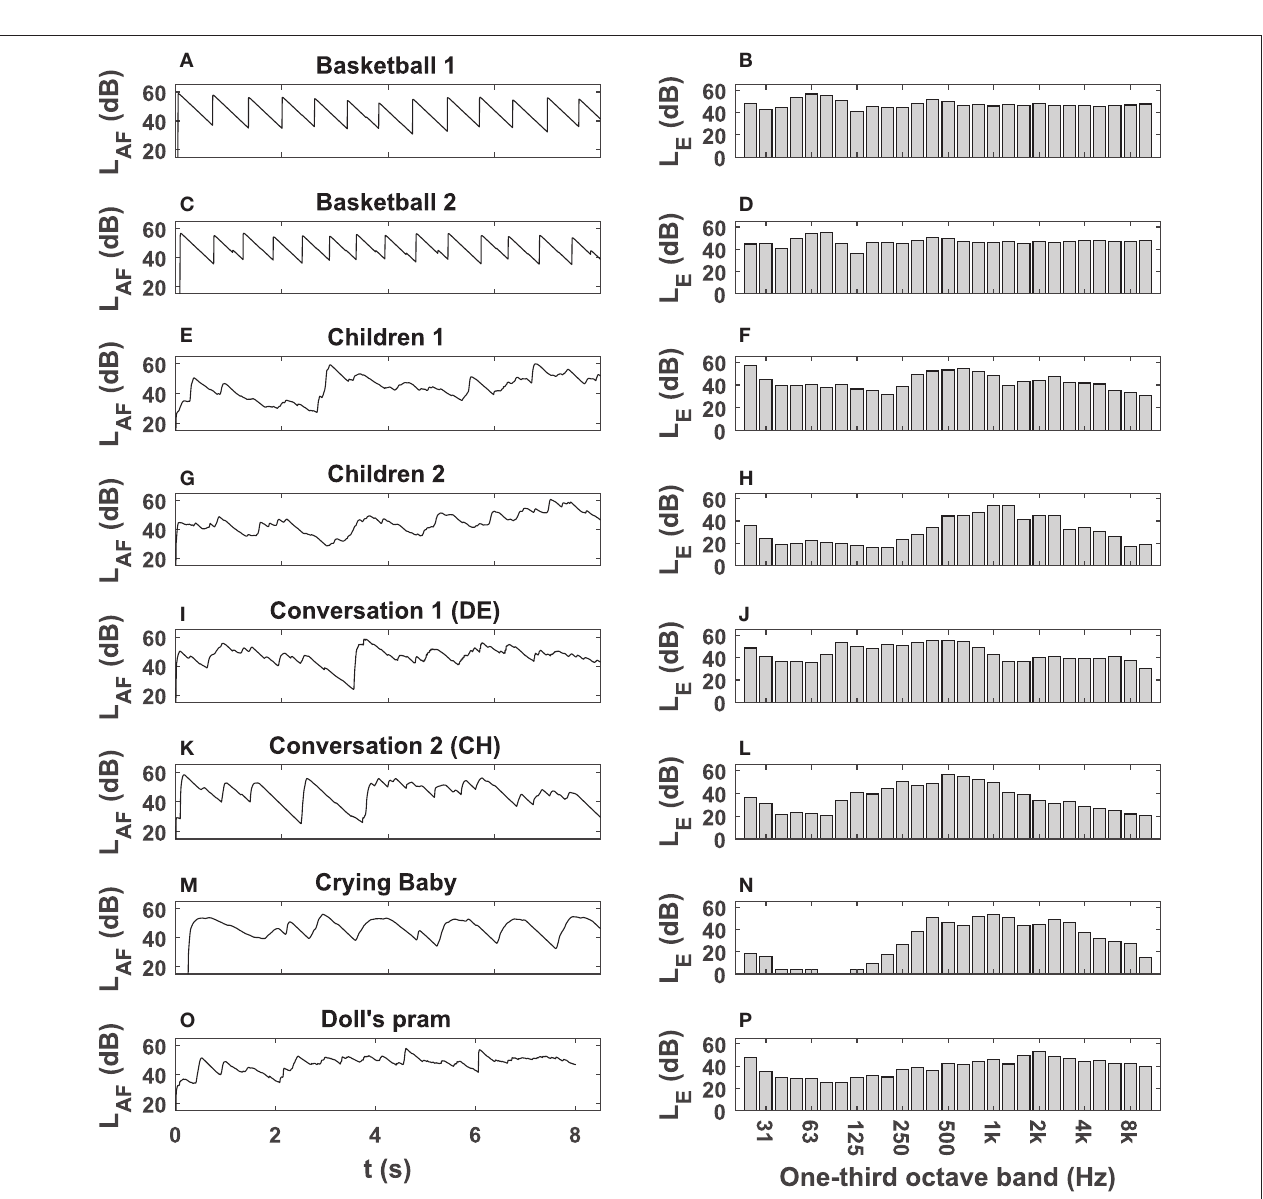
FIGURE 3 | L AF curves, i.e., A-weighted fast level-time histories (left: A,C,E,G,I,K,M,O ) and one-third octave spectra (right: B,D,F,H,J,L,N,P ) of the 8 signals used as ODEON inputs in the three experiments. All signals have an L Aeq of 50 dB(A).